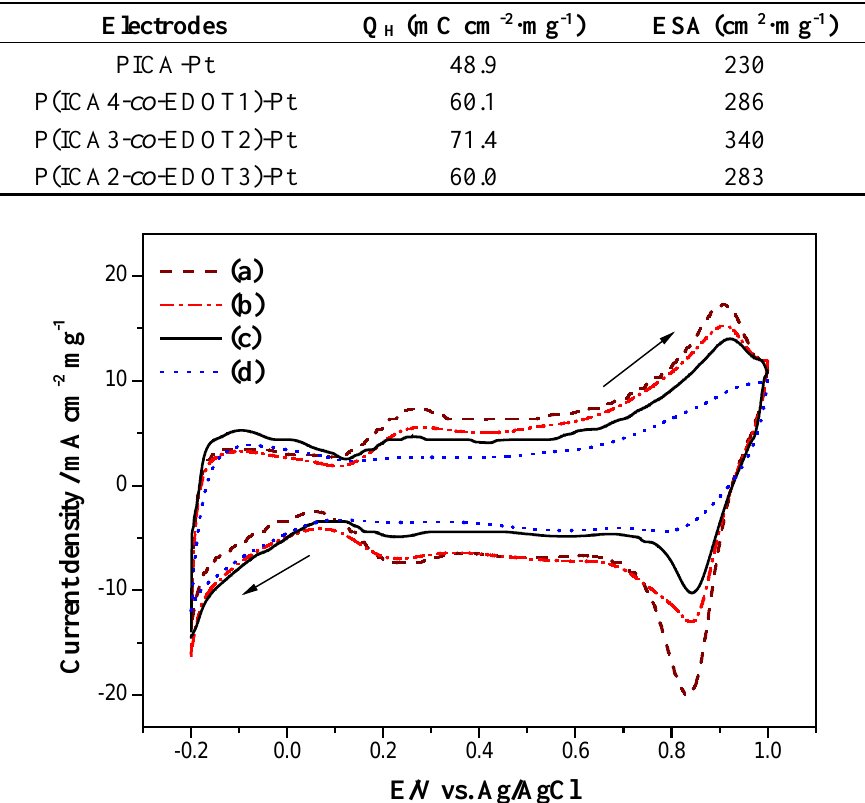
-0.2 E/V vs. Figure 8. Cyclic voltammograms of ( a ) PICA-Pt; ( b ) P(ICA4- co -EDOT1)-Pt; ( c ) P(ICA3- co -EDOT2)-Pt; and ( d ) P(ICA2- co -EDOT3)-Pt in 0.5 M H 2 SO 4 solution, the deposition charge of Pt is 0.20 C, scan rate = 50 mV·s −1 .